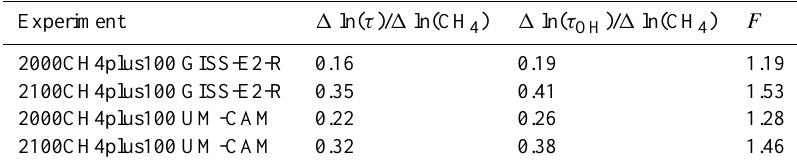
Table 5. Feedback factor ( F) ∗ and related quantities from two of the ACCMIP models and two different simulations (one for present day conditions (2000) and one for future (2100)). τ refers to the global total methane lifetime and τ OH for the global tropospheric chemical lifetime.